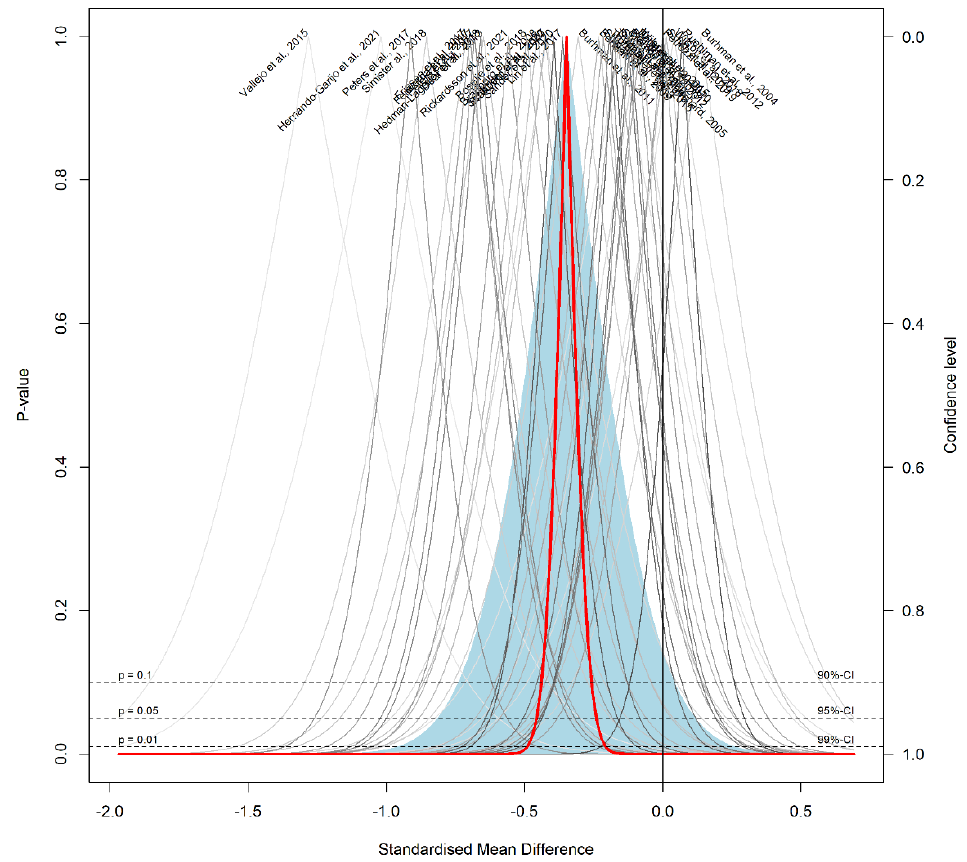
Figure A8. Drapery plot of the studies included in the sensitivity analysis.